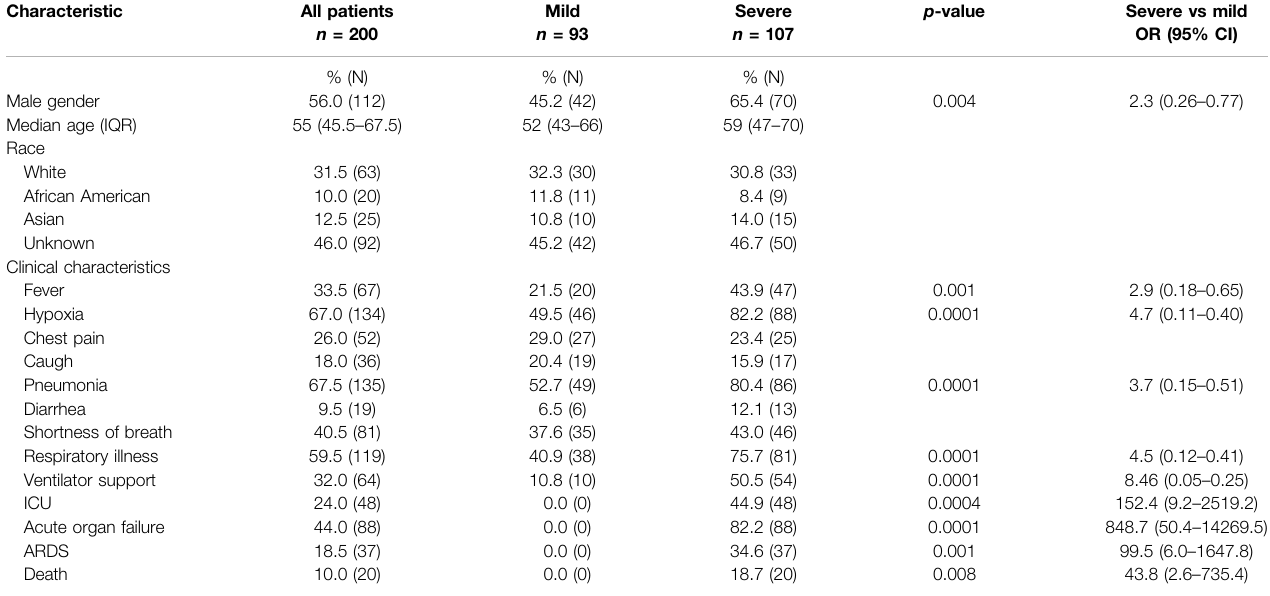
TABLE 1 | Demographic and clinical characteristics of the hospitalized COVID-19 patients.